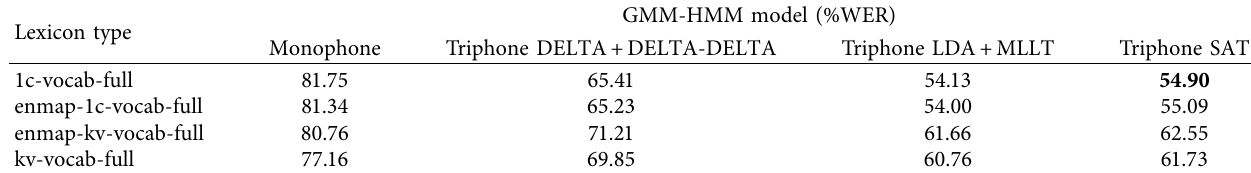
Table 10: The performance of the acoustic models using 30,000 validated utterances. Lexicon